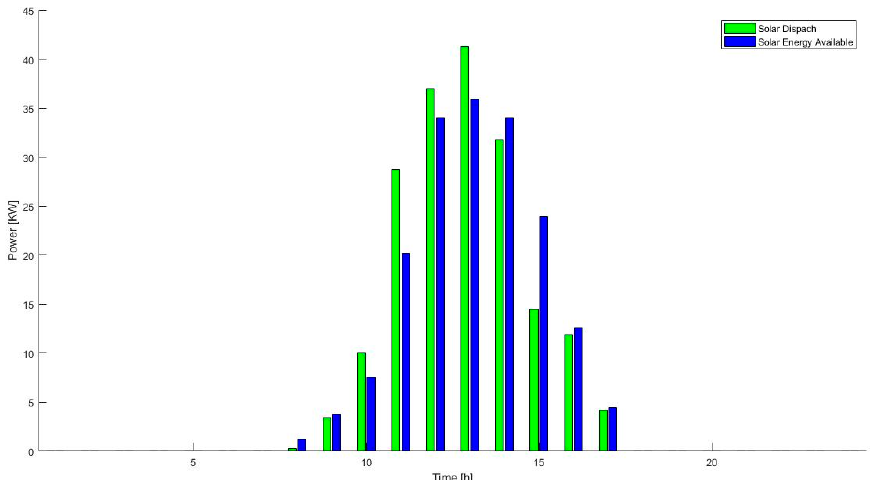
Figure 7. Availability and dispatch of the solar energy system of the MG when the storage system is after the 30% of its useful life. Energies 2020 , 13 , 957